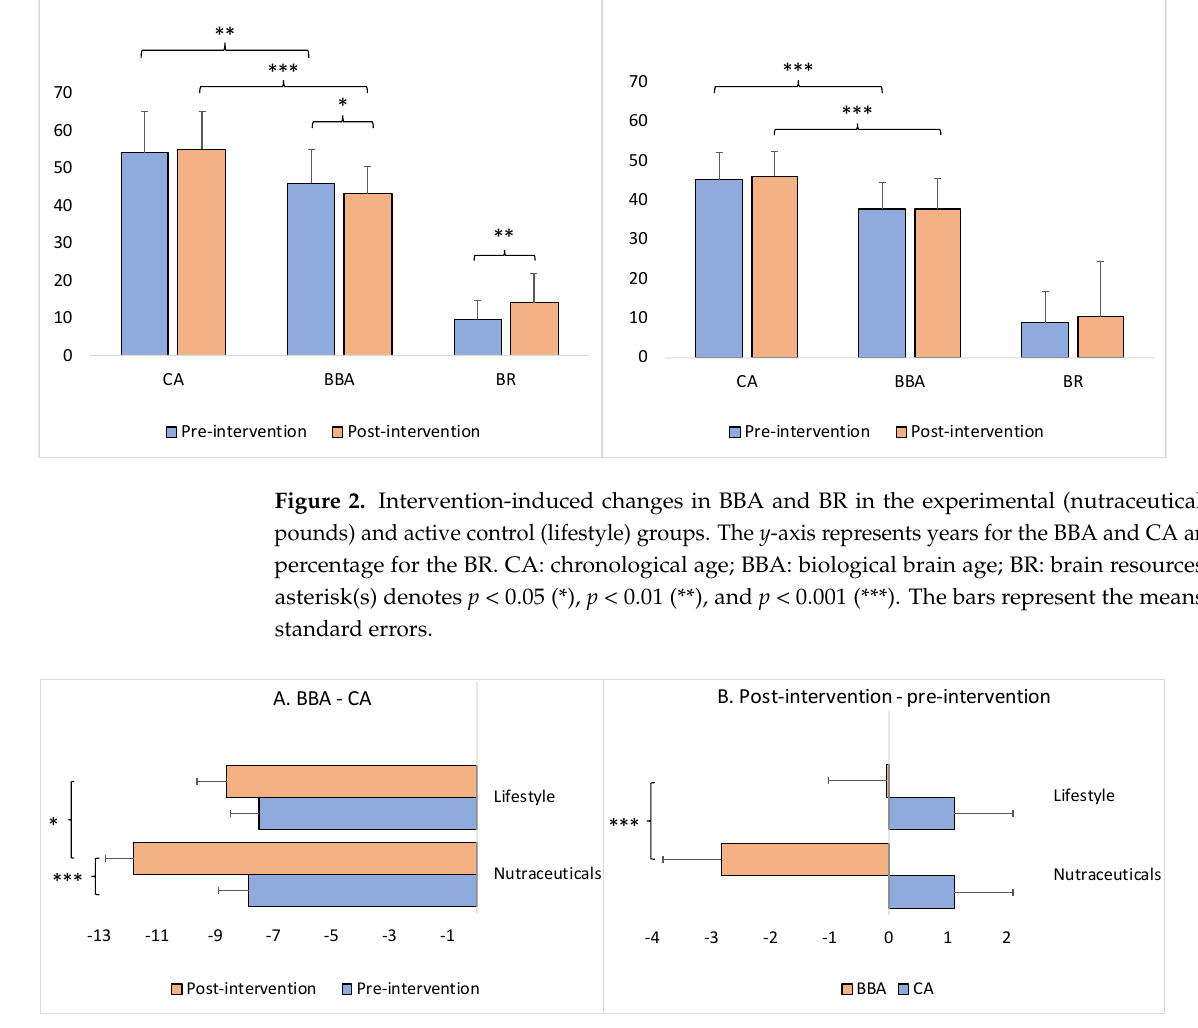
Figure 3. Difference between BBA and CA, as well as between post- and pre-intervention time-points, as a function of the intervention (i.e., nutraceutical supplementation versus lifestyle changes). The x -axis represents the difference in years. CA: chronological age; BBA: biological brain age. The asterisk(s) denotes p < 0.05 (*) and p < 0.001 (***). The bars represent the means with standard errors. ( A ) The negative values indicate that the BBA was younger than the CA (i.e., deceleration of brain aging), a “zero” value indicates that the BBA coincided with the CA (i.e., normal healthy aging), and positive values indicate that the BBA was older than the CA (i.e., acceleration of brain aging). ( B ) The negative values indicate brain age reversal, a “zero” value indicates brain age stabilization (i.e., slowdown), and positive values indicate brain